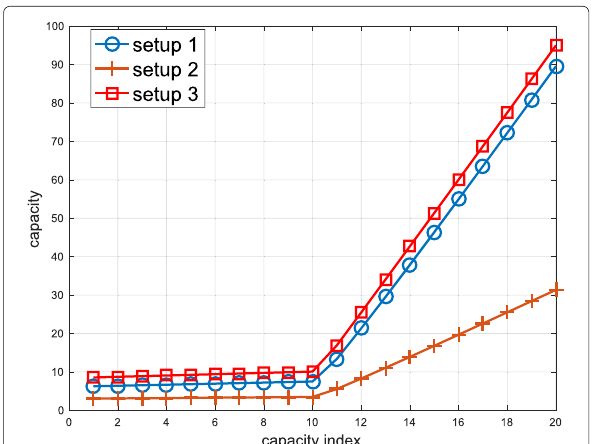
Fig. 5 Relative performance loss of hard constraint versus the index of